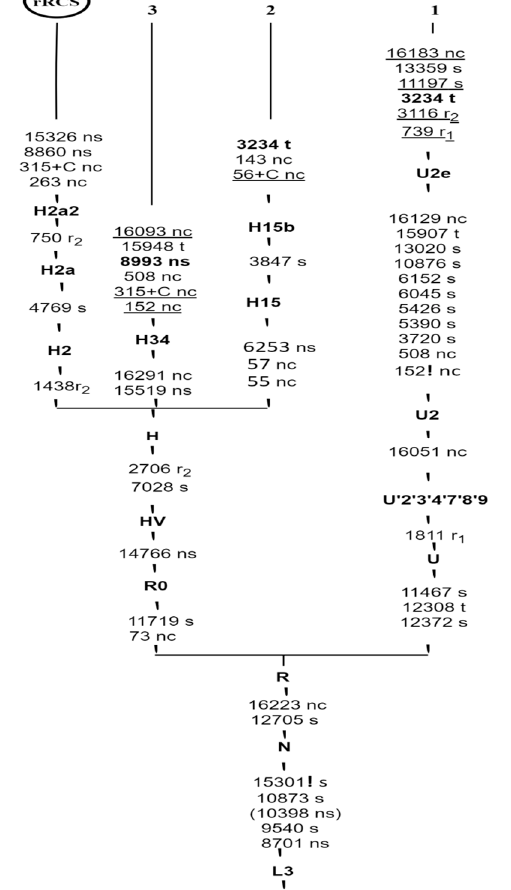
Figure 2. Phylogenetic reconstruction is presenting full mtDNA Sanger sequencing of three Serbian probands have mitochondrial encephalomyopathies mutations. The tree was rooted by following the nomenclature of mtDNA tree Build 17. ! Indicates back mutation, () indicates recurrent mutation; rCRS indicates Revised Cambridge Reference Sequence; nc, s, ns, t, r 1 and r 2 indicate non-coding region, synonymous, nonsynonymous, transfer RNA, ribosomal RNA1, and 2 variants, respectively. Primary mitochondrial encephalomyopathies mutations are shown in bold, 3243 for MELAS and 8993 for Leigh syndrome. Underlining indicates variants specific for haplogroups reported on Mitomaster analysis vs. PhyloTree Build 17.